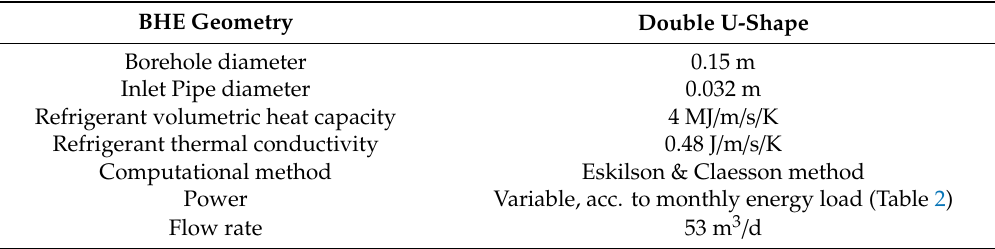
Figure 3. Double U-shaped pipe scheme. Table 1. Borehole heat exchanger (BHE) settings.